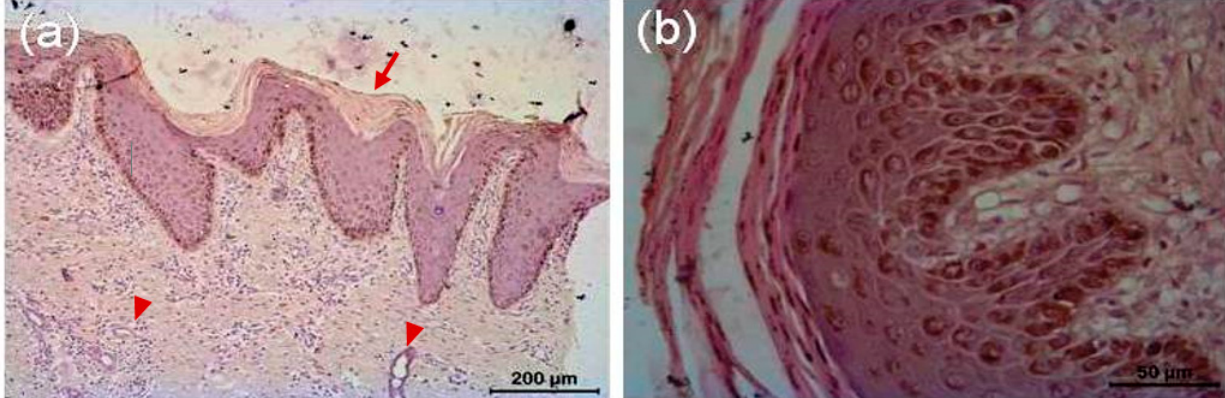
Figure 7. Histopathology of skin of tri-model therapy-treated animal. ( a ) Skin of treated animal shows epidermis and dermis with its different layers, almost normal Stratum corneum ; devoid of its nucleus (arrow), Stratum spinosum and granulosum are well appreciated. Sweat glands (arrow head) are evident in the region between papillary and reticular layer of dermis. There is no infiltration. Adnexal structure is present in the biopsy material. ( b ) Different layers of epidermis after